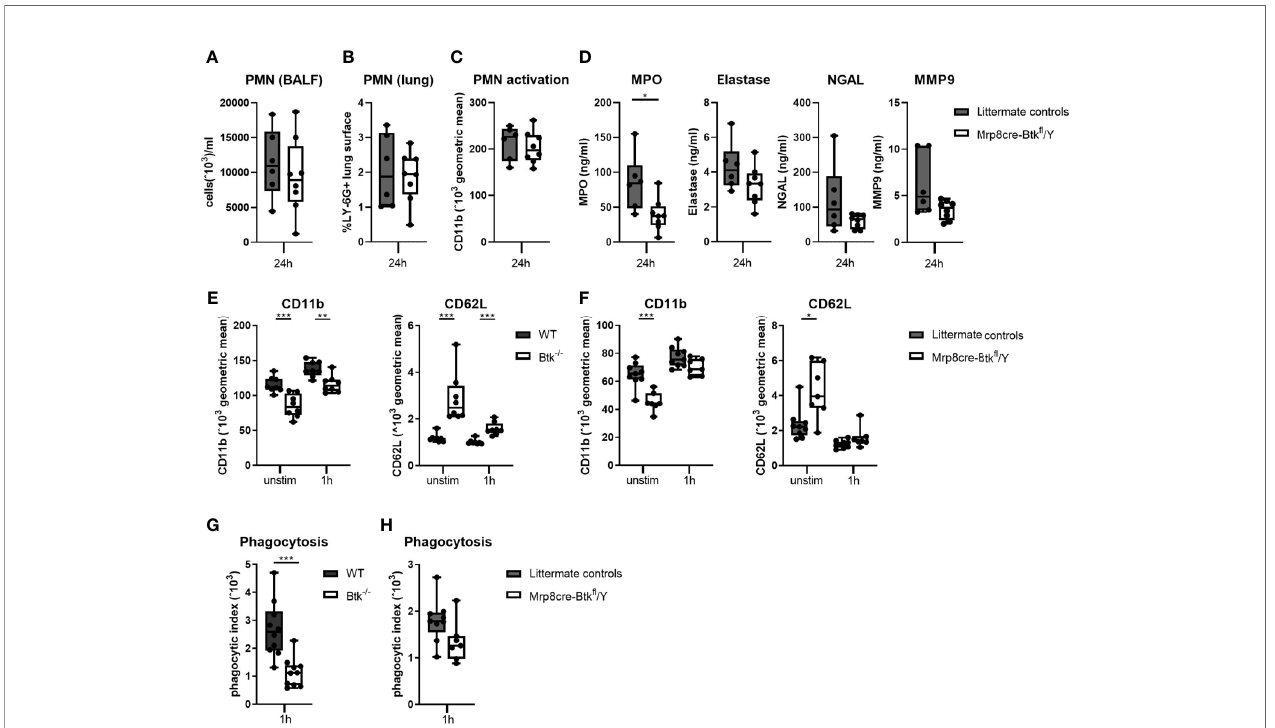
FIGURE 6 | Btk de fi cient neutrophils show reduced effector functions in response to LTA and pneumococci. (A-D) Mrp8cre-Btk fl /Y (n=6) and littermate controls (n=8) were sacri fi ced 24 hours after intranasal administration of lipoteichoic acid (LTA). (A) Numbers neutrophils (PMN) in BALF. (B) Percentage of LY-6G positive lung surface. (C) CD11b expression (geometric mean) on BALF PMN. (D) BALF concentrations of the PMN degranulation products myeloperoxidase (MPO), elastase, neutrophil gelatinase-associated lipocalin (NGAL) and matrix metallopeptidase 9 (MMP9). (E, F) CD11b and CD62L surface expression on blood neutrophils from (E) WT and Btk -/- (n=8 per group) and (F) littermate control and Mrp8creBtk fl /Y (n=7-9 per group) at baseline or after stimulation for 1 hour with D39. (G, H) Whole blood of (G) WT and Btk -/- mice (n=10 per group) or (H) littermate control and Mrp8creBtk fl /Y mice (n7-9 per group) was incubated for 60 minutes with FITC- labelled D39 after which the neutrophil phagocytic index of was determined. Data are expressed as box- and whisker plots showing the smallest value, lower quartile, median, upper quartile and largest value. *p < 0.05, **p < 0.01, ***p < 0.001, Mann-Whitney U